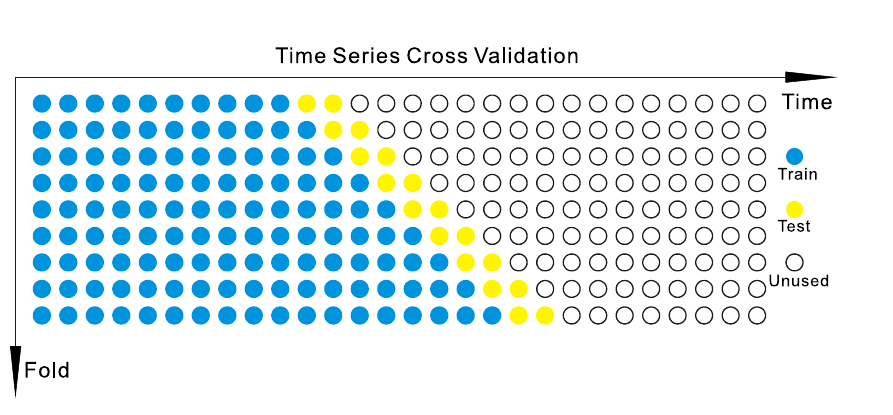
Fig 11. Time series